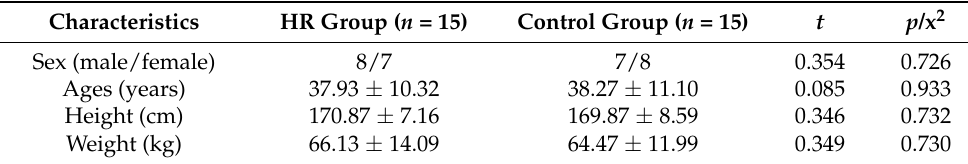
Table 1. General characteristics of participants (N =